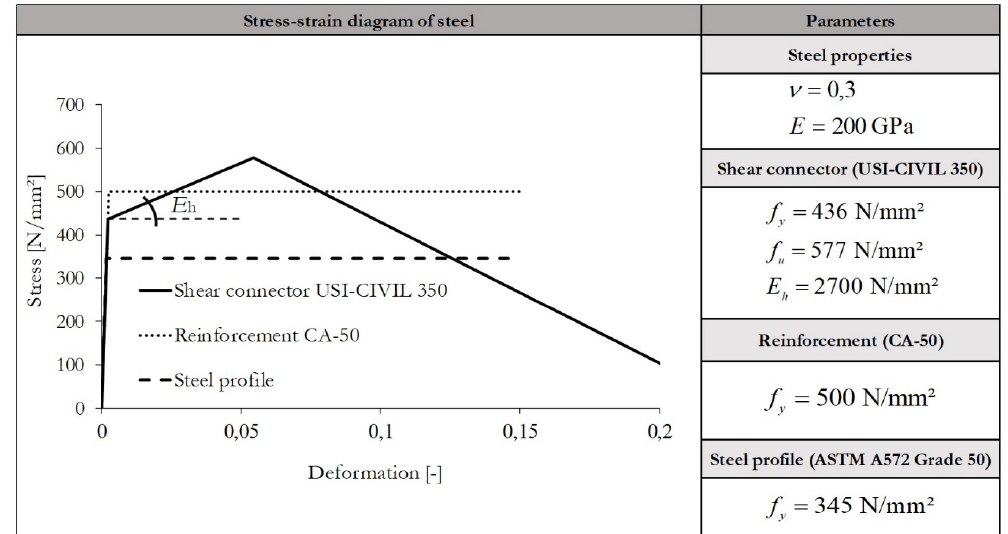
Figure 12. Material model for steel